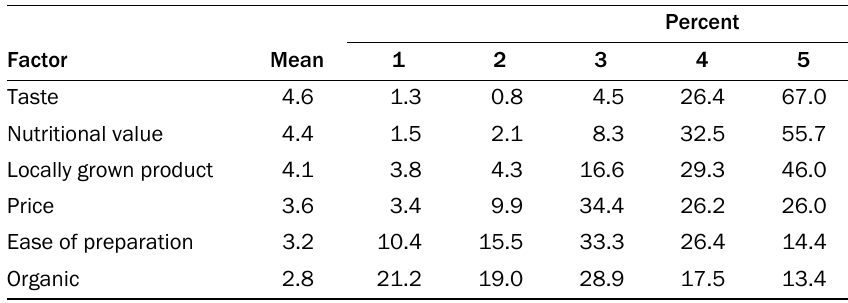
Table 2. Factors That Influence Types of Food Purchesed, by